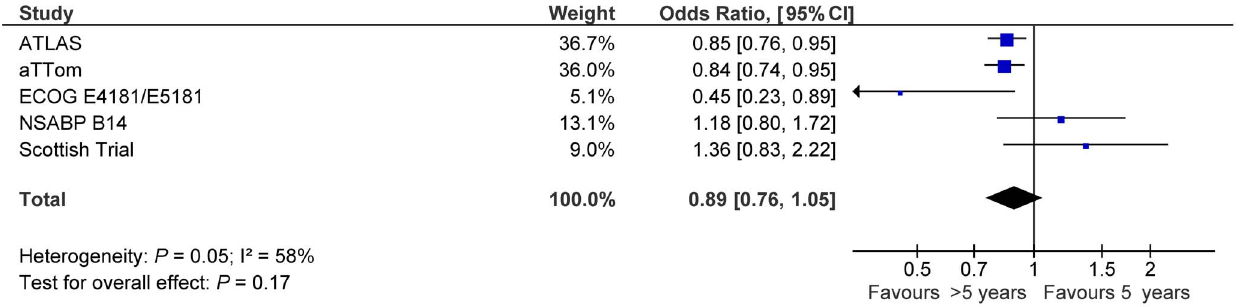
Figure 2. Forest plots of odds ratios for breast cancer recurrence for patients treated with extended adjuvant tamoxifen ( . 5 years) versus adjuvant tamoxifen (5 years) based on primary analysis of individual trials. Odds ratios for each trial are represented by the squares , the size of the square represents the weight of the trial in the meta-analysis, and the horizontal line crossing the square represents the 95% confidence interval. The diamonds represent the estimated pooled effect (labeled